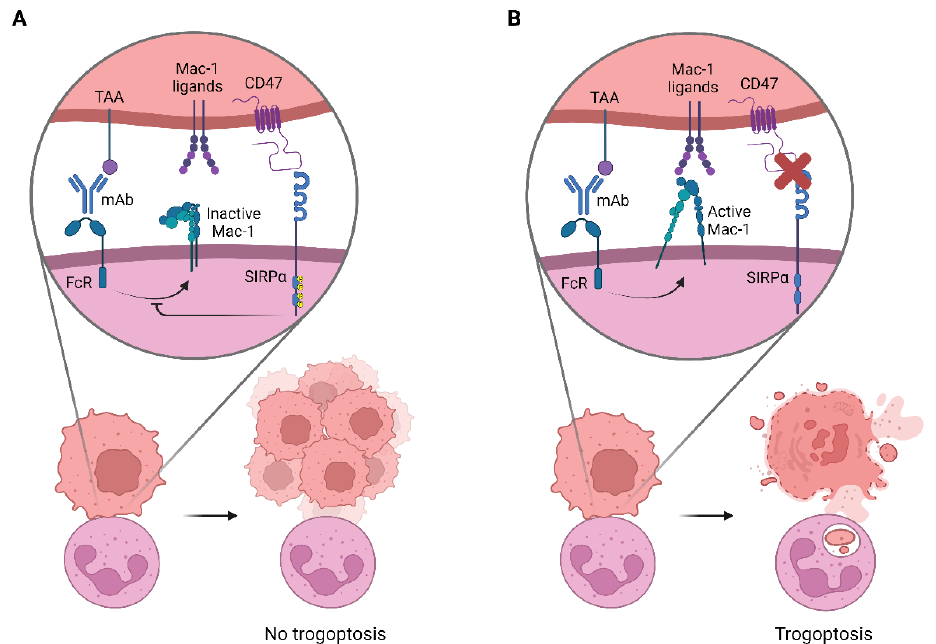
Figure 3. CD47-S IRPα signaling prevents neutrophil -mediated tumor cell killing. ( A ) Ligation of CD47 and SIRP α controls integrin (Mac -1) activation on neutrophils. This subsequently results in CD47 and SIRP α controls integrin (Mac-1) activation on neutrophils. This subsequently